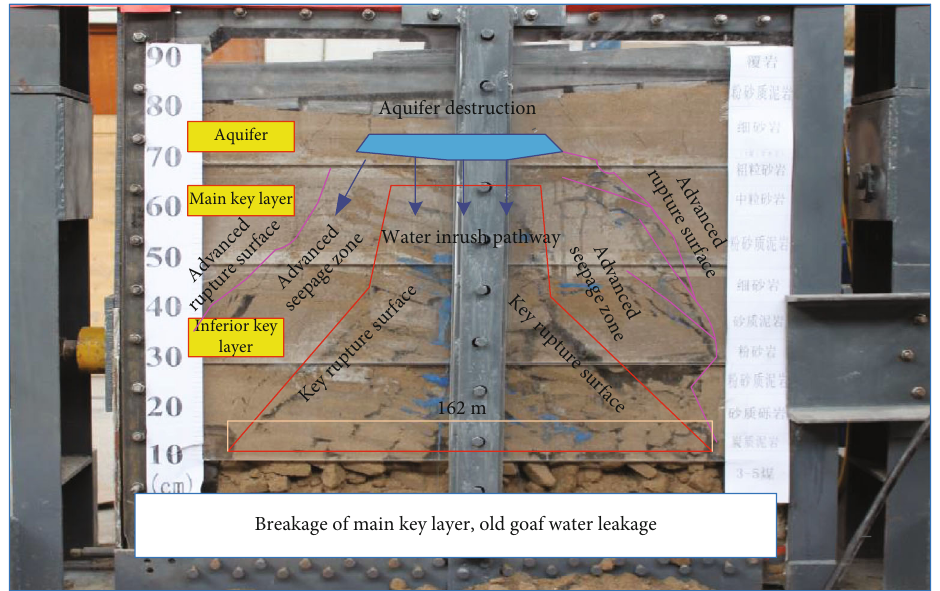
Figure 13: Distribution of broken main key layer and water-conducting